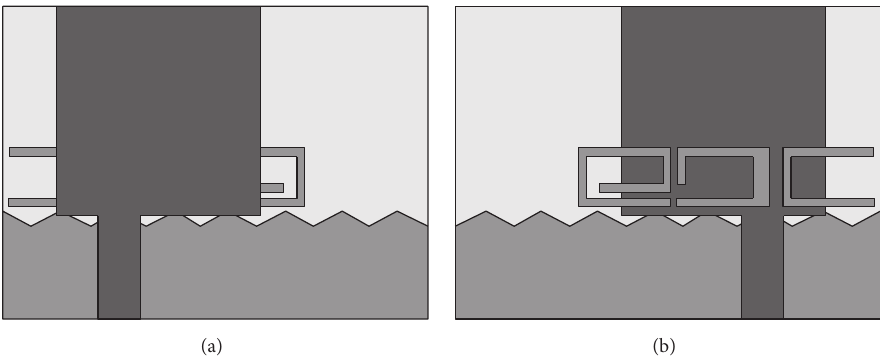
Figure 22: Monopole antenna printed on a sawtooth ground plane [77]. Resonant filters used to limit the electromagnetic emission in the frequency bands 3.26–3.71 GHz, 5.15–5.37 GHz, and 5.78–5.95 GHz are shown in figure. Top view (a) and bottom view (b). Dark gray upper metal face, medium gray bottom metal face, and light gray dielectric substrate.